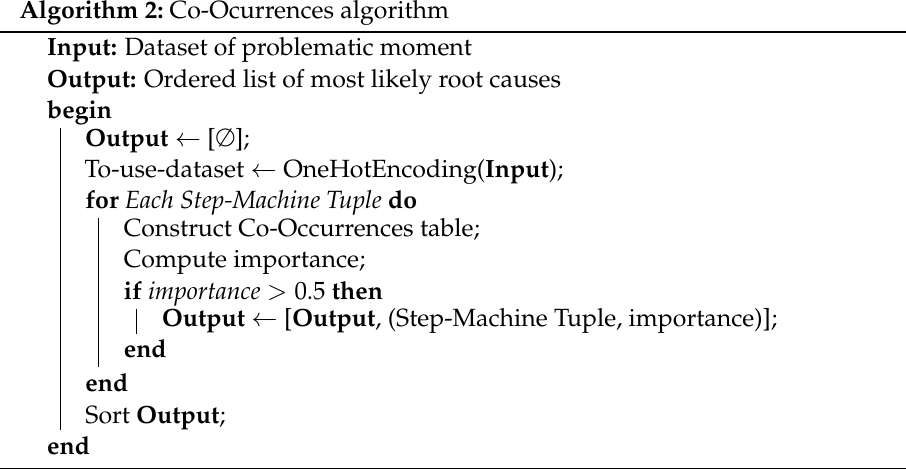
Algorithm 2: Co-Ocurrences